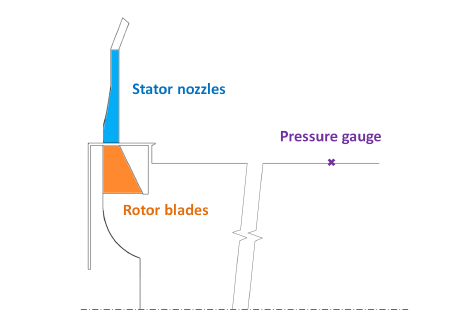
Figure 11. Approximate location of the pressure gauge.